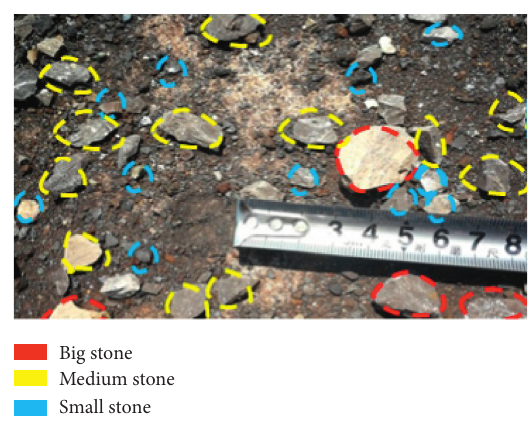
Figure 6: Particle size of splash stone at the site.